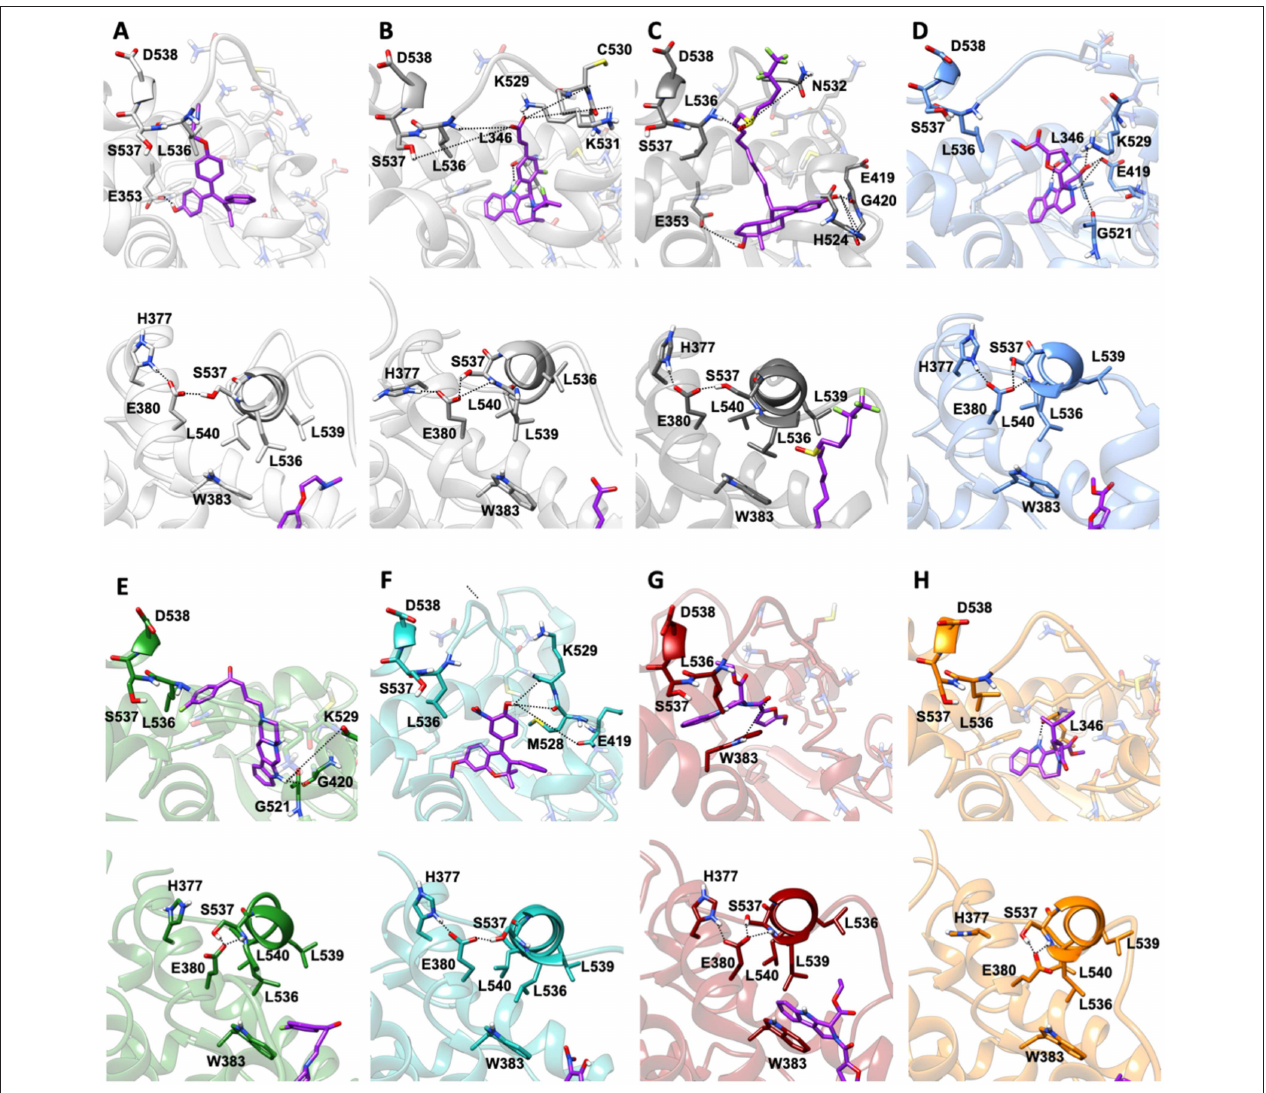
FIGURE 6 | Binding of the five active molecules to Y537S ER α as compared with END, AZD, and FULV. (A) END; (B) AZD; (C) FULV; (D) compound 19 ; (E) 9 ; (F) 13 ; (G) 20 ; (H) 21 . Top panels show their placement in the ligand binding cavity, while bottom panels display a close view of E380 H-bond network induced by each ligand. Inhibitors are shown in licorice with carbon atoms in purple color, while oxygen and nitrogen are shown in red and blue, respectively. Protein is depicted in gray new cartoons for END, AZD, FULV, and blue, green, light green purple orange new cartoons for 19 , 9 , 13 , 20 , 21 , respectively.